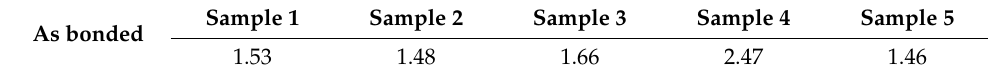
Table 1. Hermeticity tests ( × 10 − 4 Pa · cm 3 /s).